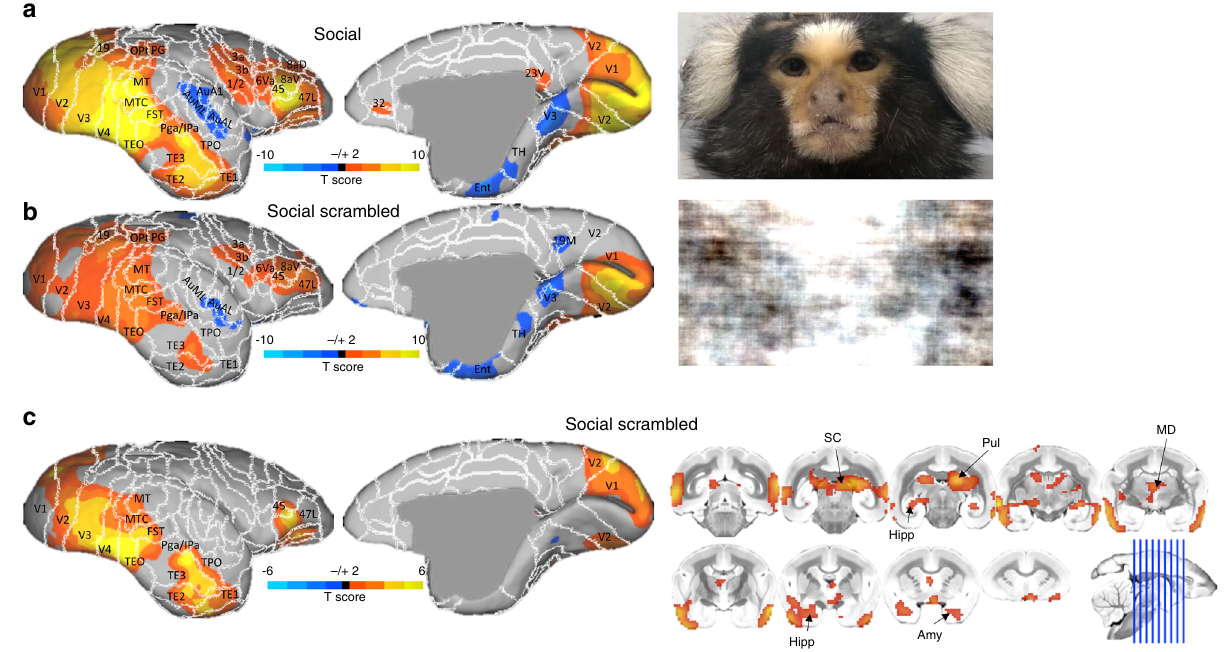
Fig. 1 Face processing topologies. Group functional topology comparisons between social (i.e., directed and averted gaze) and nonsocial scrambled video conditions displayed on a marmoset cortical surface. a shows group topologies for social videos and b shows topologies for social scrambled videos, with stills of representative stimuli to the right of each surface. c shows the contrast between the social and scrambled conditions, with volumetric display (to show subcortical activation) to the right of the medial and lateral